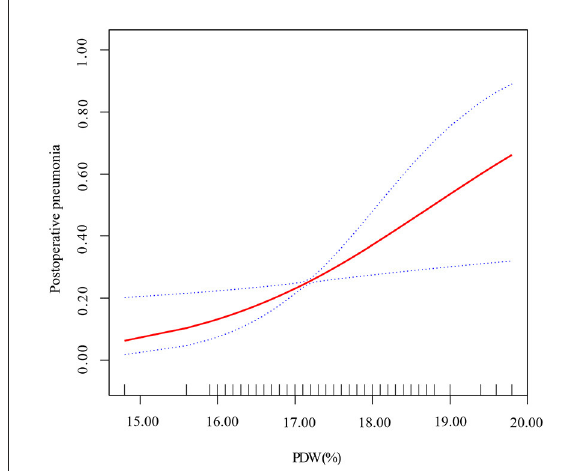
FIGURE3 Smoothing spline fitting curve. Adjusted variables: age; gender; neutrophils; hematocrit; duration of ventilator; RBCs; plasma; cryoprecipitate; hospital and ICU stay. The linear plots are displayed with red dotted lines, and the blue dotted lines represent 95%